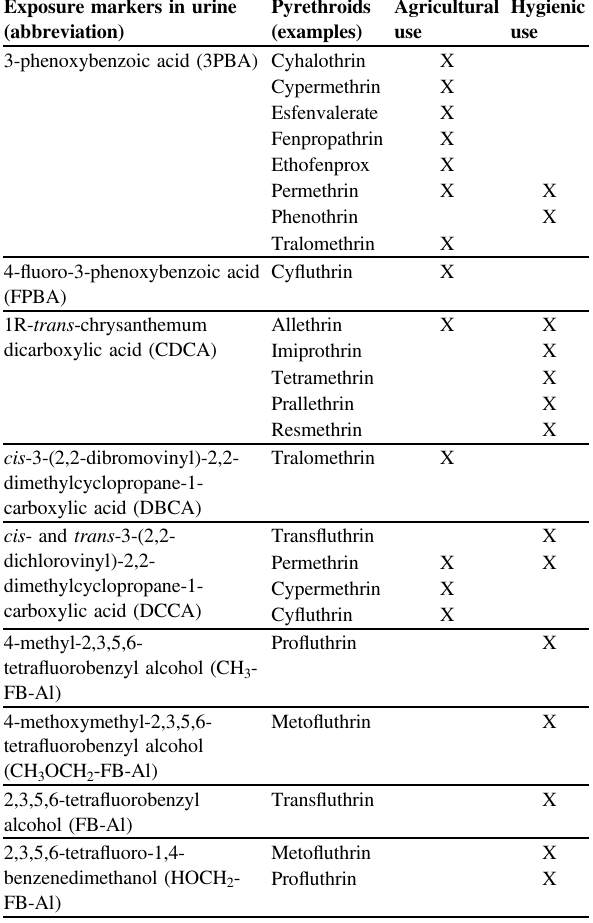
Table 1 Pyrethroid (PYR) exposure markers, selected pesticides, and the